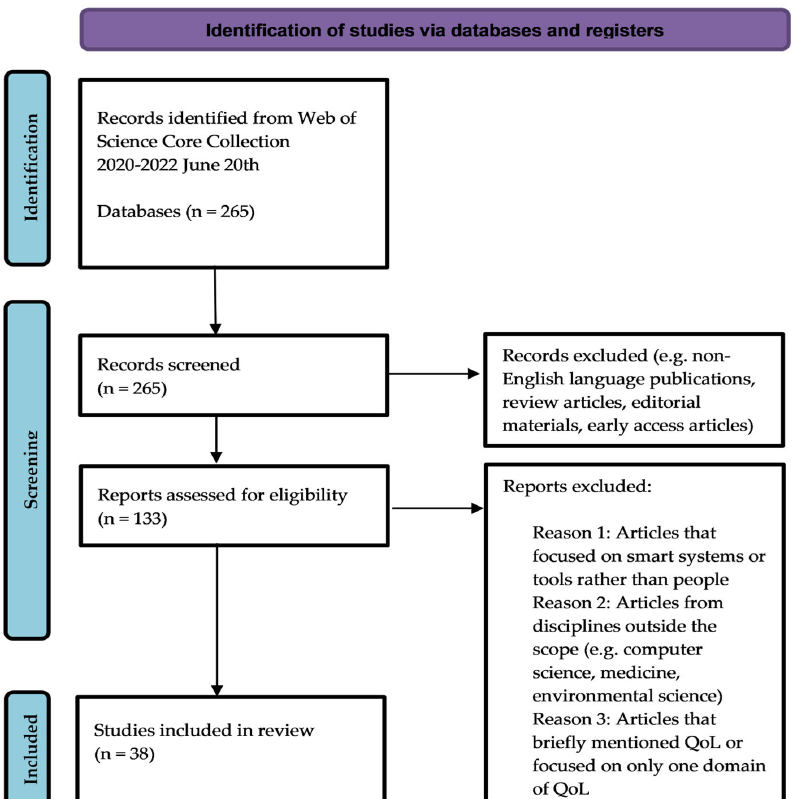
Figure 1. PRISMA model. Source: Authors’ own (2023).